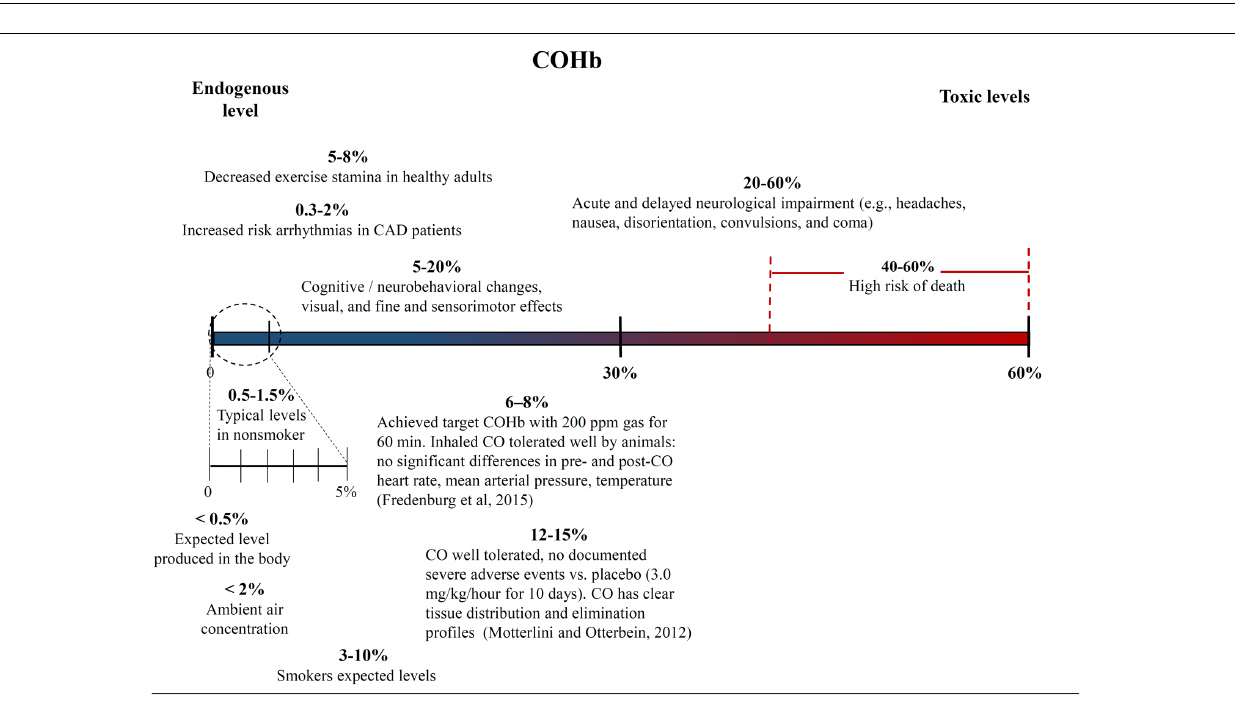
FIGURE 5 | Carboxyhemoglobin (COHb) concentrations in the blood and corresponding medical effects for both environmental conditions and controlled supplementary CO therapy. Negative and positive medical effects are shown on the top and bottom, respectively (Motterlini and Otterbein, 2010; Fredenburgh et al., 2015). The effects without corresponding citations are from a CDC publication (Wilbur et al.,